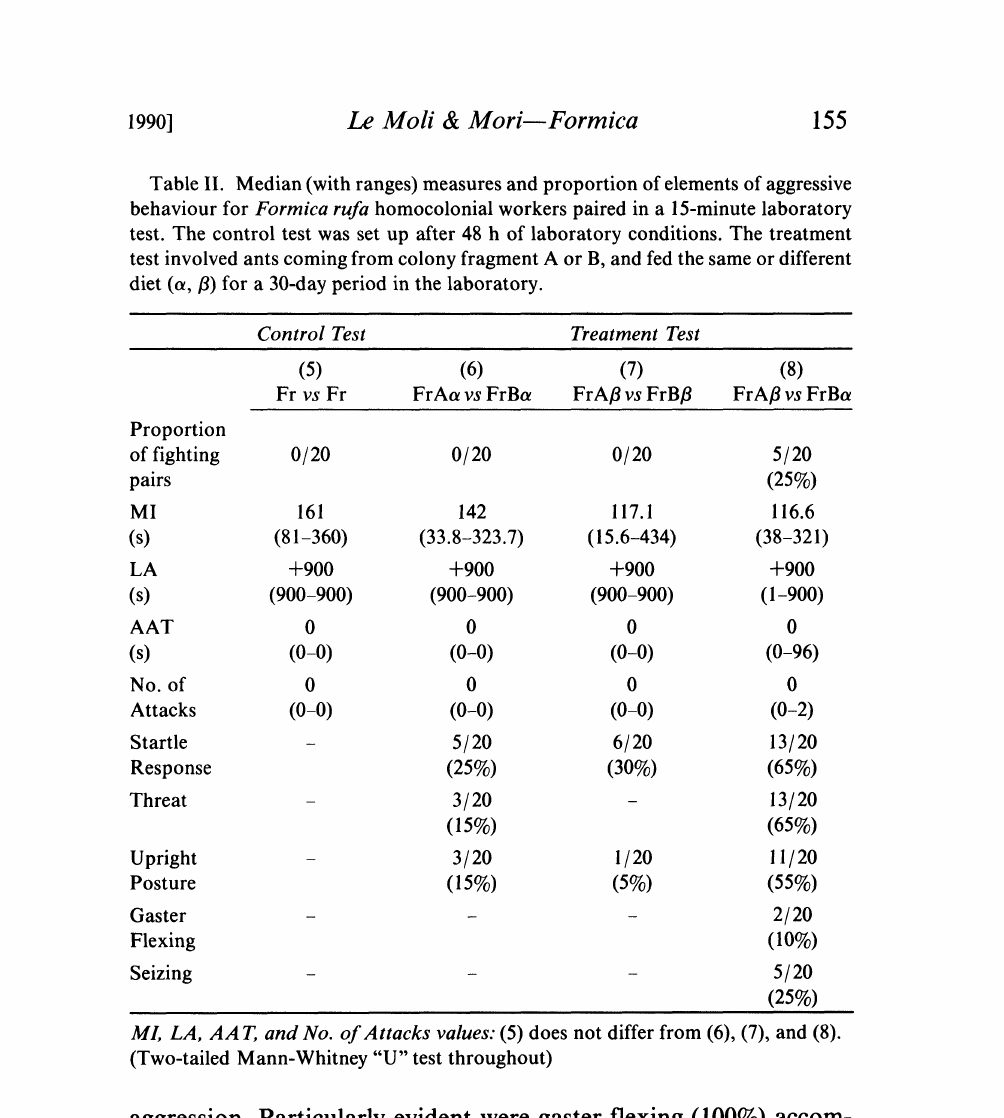
Table II. Median (with ranges) measures and proportion of elements of aggressive behaviour for Formica rufa homocolonial workers paired in a 15-minute laboratory test. The control test was set up after 48 h of laboratory conditions. The treatment test involved ants coming from colony fragment A or B, and fed the same or different diet (a,/3) for a 30-day period in the